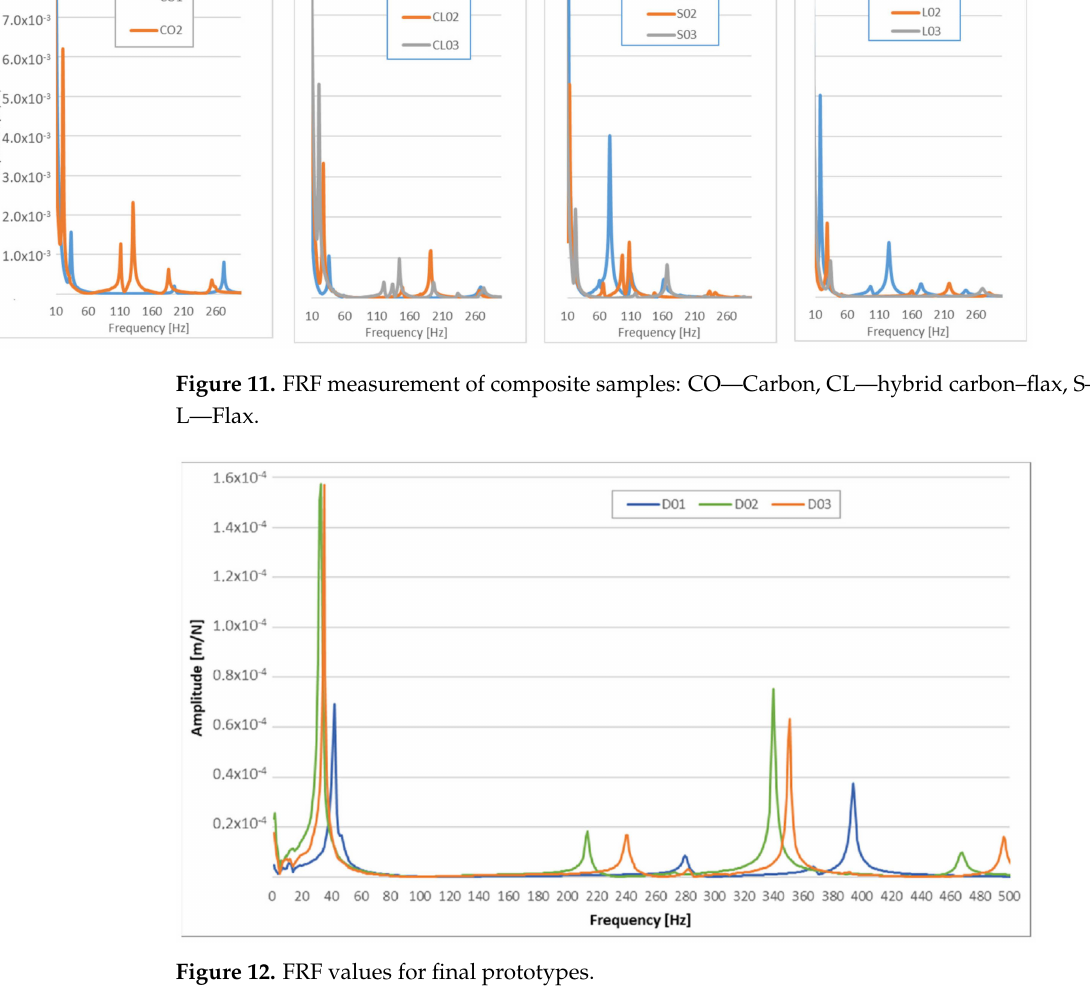
Figure 12. FRF values for final